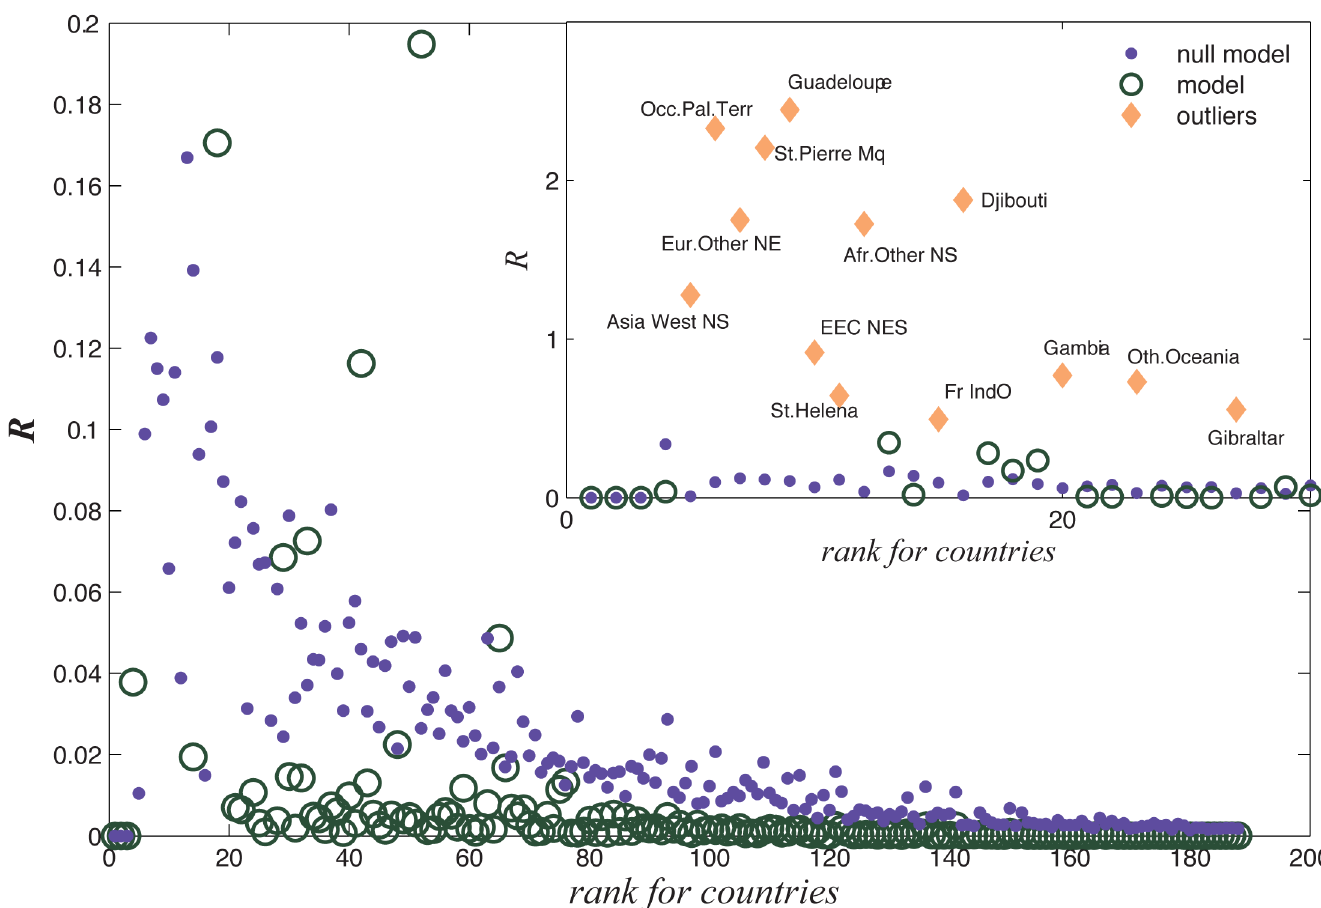
Fig 4. Relative entropies between the theoretical and the empirical results measured by the Kullback-Leibler Distance for all countries. Blue dots are the relative entropies for the Null model and the red hollow circles are those for the theoretical model. Insets show the outliers with very large errors (larger than